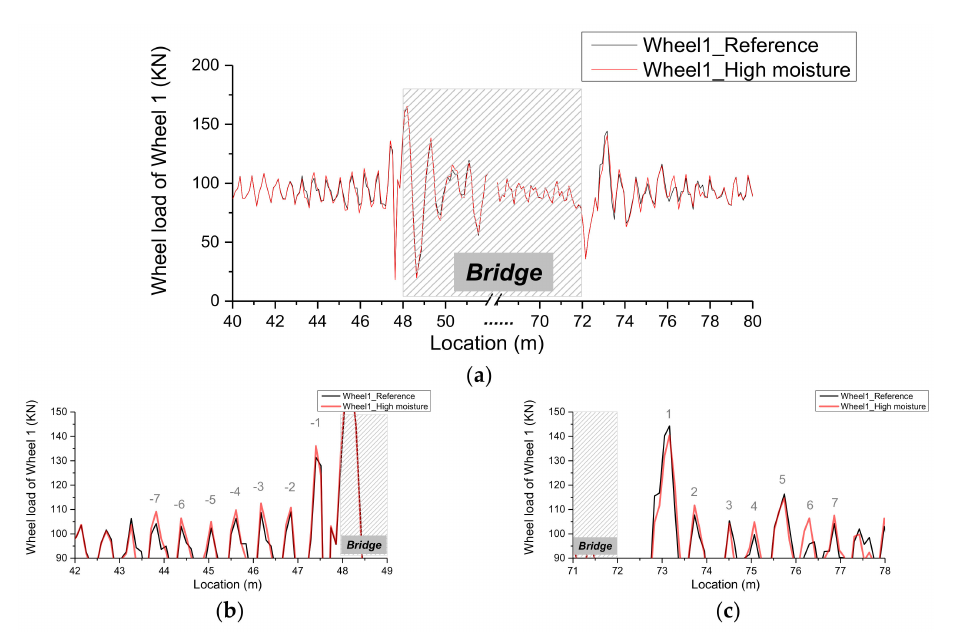
Figure 14. Dynamic wheel load of Wheel 1: ( a ) overview; ( b ) zoom-in of the embankment-bridge side; and, ( c ) zoom-in of the bridge-embankment side (unit: